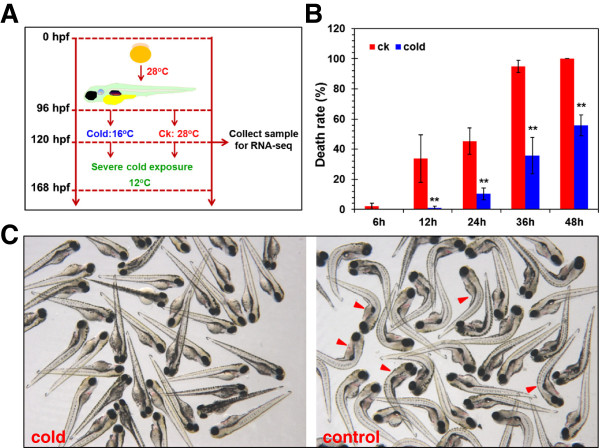
Establishment of cold resistance in zebrafish larvae after pre-exposure to cold stress. (A) Flowchart of cold exposure. Zebrafish embryos were incubated at 28°C from fertilization to 96 hpf. Larvae at 96 hpf were exposed to 16°C for 24 h and the controls were maintained at 28°C. Samples for RNA-seq were collected at 120 hpf. The pre-treated and control larvae were further exposed to 12°C for 6, 12, 24, 36 and 48 h. The time scales were shown on the left. (B) Death rates of pre-treated and control (ck) larvae exposed to 12°C for different times. Data was shown as mean ± standard deviation (n = 4). “**” above error bars indicate p < 0.01. (C) Images of pre-treated and control larvae exposed to 12°C for 36 h. Images were taken under a stereomicroscope from Zeiss with a color CCD camera. Red arrowheads indicate representative dead larvae.